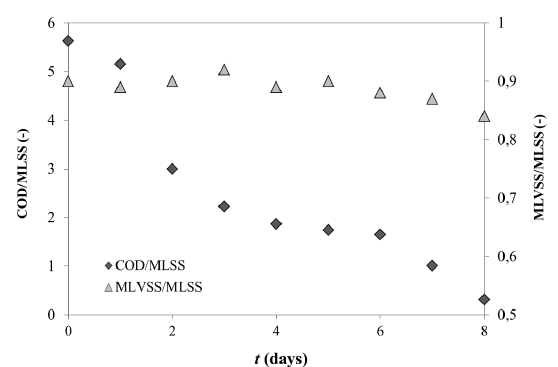
Figure 2. Changes in COD/MLSS